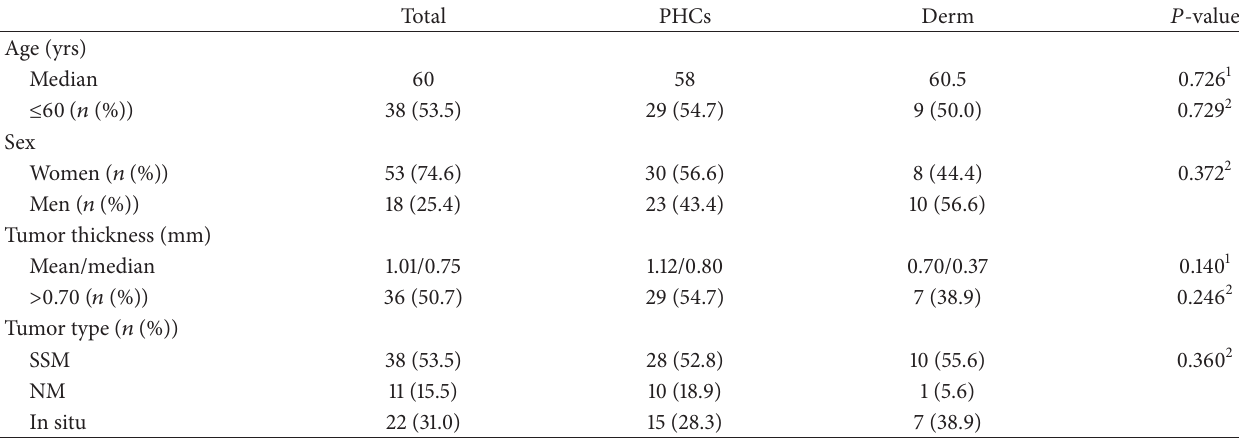
Table 3: Comparison between primary health-care centers (PHC) and dermatological and other clinic groups (Derm) as related to age, sex, tumor thickness, and